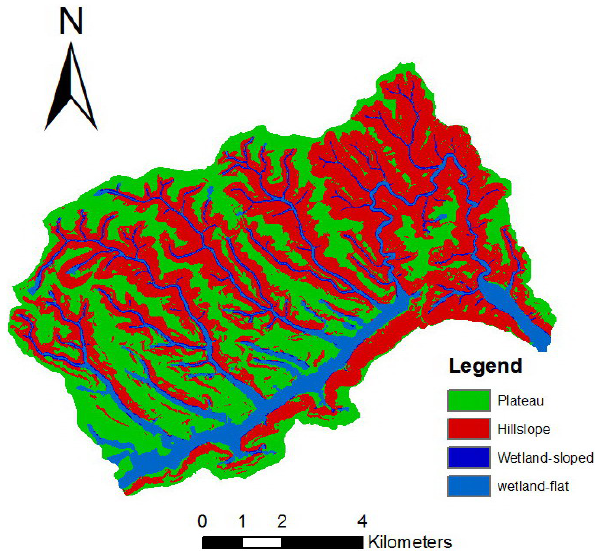
Fig. 10. Classified map of the Wark catchment resulting from the best model performance M SHopt .